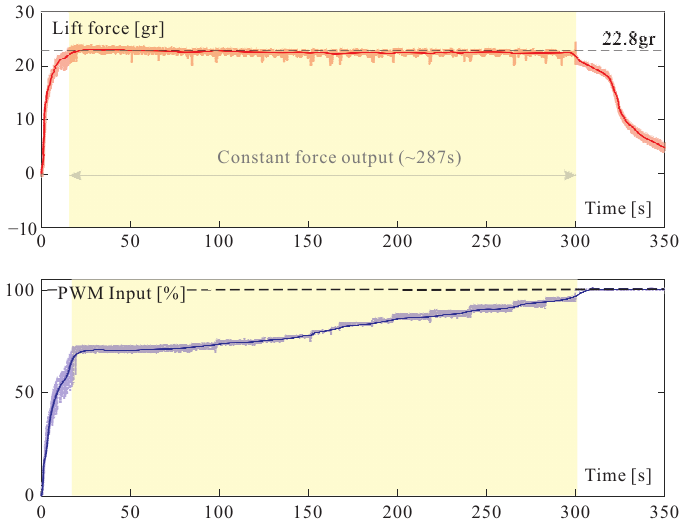
Figure 15. Endurance experiment. Top : Time history of the lift force. Bottom : Time history of the duty factor µ of the PWM. The lift drops suddenly when µ reaches